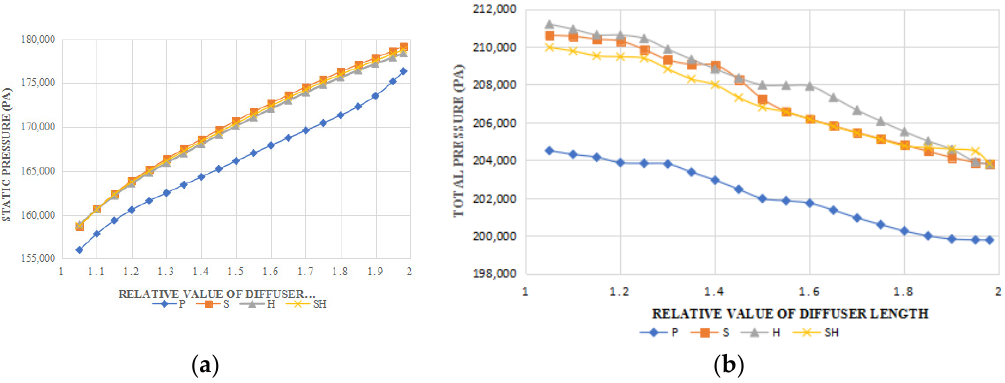
Figure 12. Mean static pressure and total pressure distribution along the diffuser length direction at 1 relative mass flow: ( a ) static pressure distribution; ( b ) total pressure distribution.